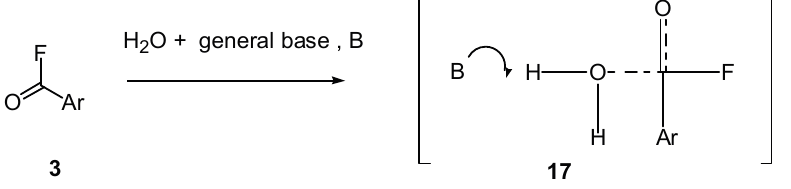
Figure 13. General base catalysis mechanism [9] for hydrolysis of benzoyl fluoride ( 3